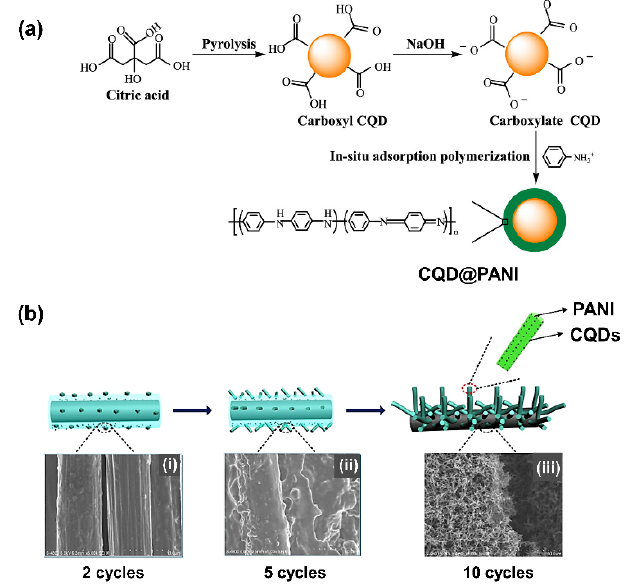
Figure 8. ( a ) Schematic illustration of the synthesis of core shells C-QDs@PANI by pyrolysis: reproduced with permission from Reference [149]. Copyright Elsevier, 2019. ( b ) Schematic illustrations and corresponding SEM images of the C-QDs-PANI/CFs(LI) prepared by cyclic voltammetry (CV) electrodeposition in varying cycles of 2, 5, and 10: (i) 2 cycles; (ii) 5 cycles; (iii) 10 cycles. Reproduced from Reference [162]. Copyright Elsevier, 2017.